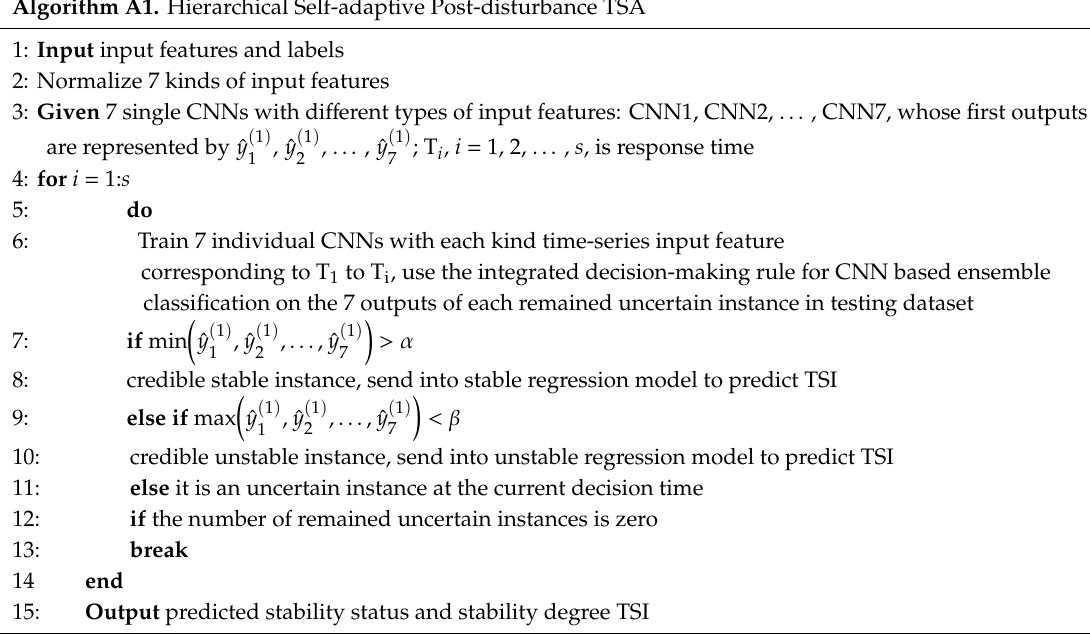
Algorithm A1. Hierarchical Self-adaptive Post-disturbance TSA